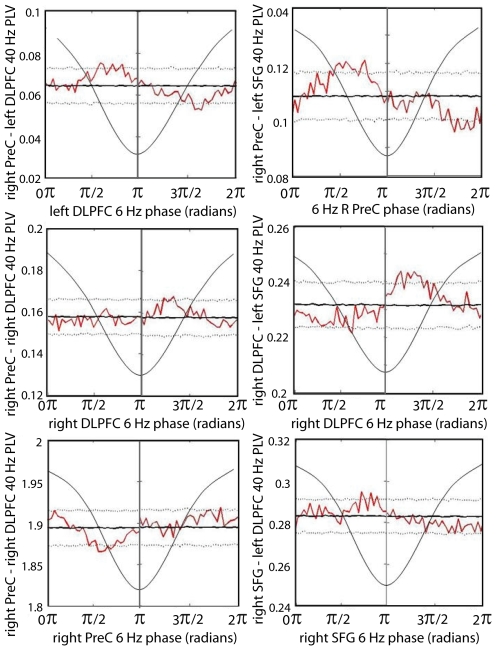
Theta-modulation of gamma-band inter-regional phase locking.Dotted lines represent the 97.5 (top) and 2.5th (bottom) percentiles and the dark black line indicates the mean of the surrogate distribution for each of the 60 bins of the theta cycle. Jagged red line denotes the non-normalized gamma-band phase locking value in each bin. When phase-locking was greater than or less than the surrogate line for two or more successive bins we considered the departure to be significant (p<0.05, two-tailed). Radians on the x-axis are in reference to a cosine wave, which is maximal at 0 radians; one cycle of a 6 Hz cosine wave (thin black line) is superimposed on the graph.